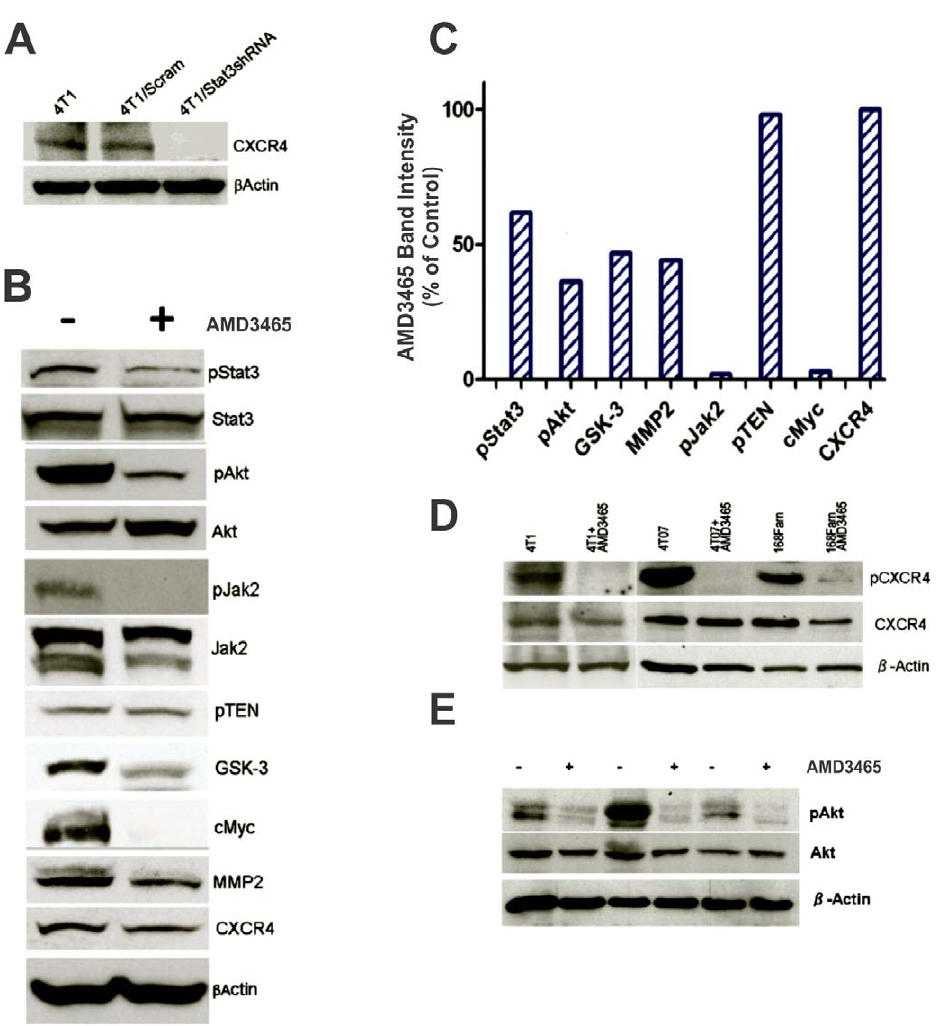
Figure 2. AMD3465 modulates intracellular oncogenic signaling mediators in mouse breast cancer cell lines. A, A western blot analysis showing a 24-h knockdown of STAT3 expression using shRNA in the 4T1 cells and the concomitant abrogation of CXCR4 expression. B, Western blot analysis of oncogenic intermediates following a 24-h treatment of the 4T1 cells with 5 m M AMD3465. The band intensities ware normalized relative to b -actin expression and presented as % of Control in C . D and E, Western blot analyses of oncogenic intermediates following a 24-h treatment of the 4T1, 4T07, and 168Fran cells with 5 m M AMD3465.